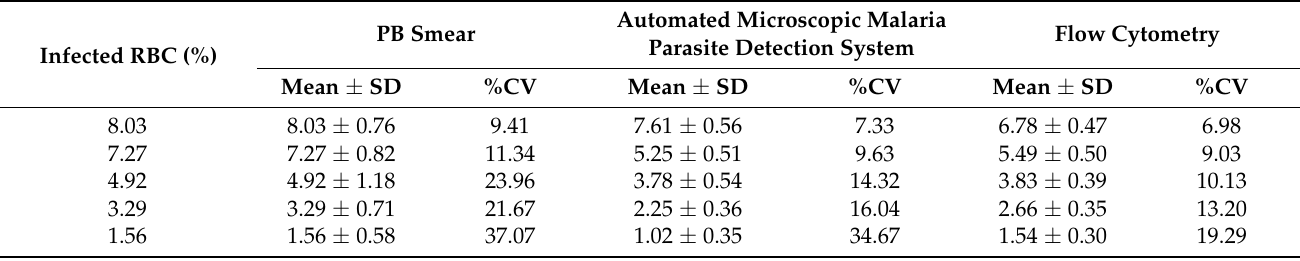
Table 1. Precision of parasitemia measured with PB smears, the automated microscopic malaria parasite detection system, and flow cytometry using P. falciparum malaria cultures for various levels of parasitemia.